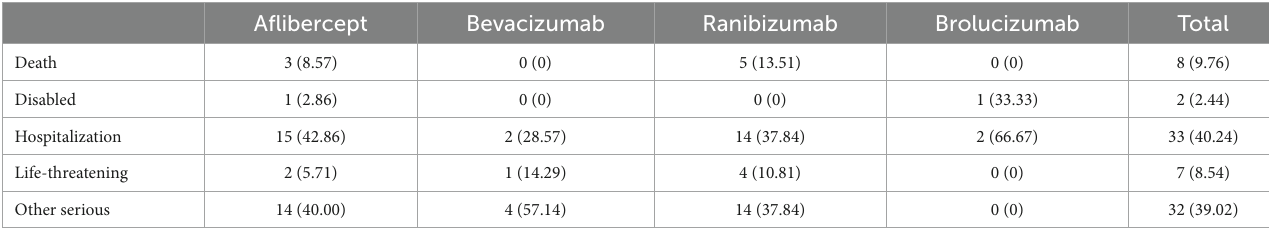
TABLE 4 Outcomes after intraocular VEGF-associated renal